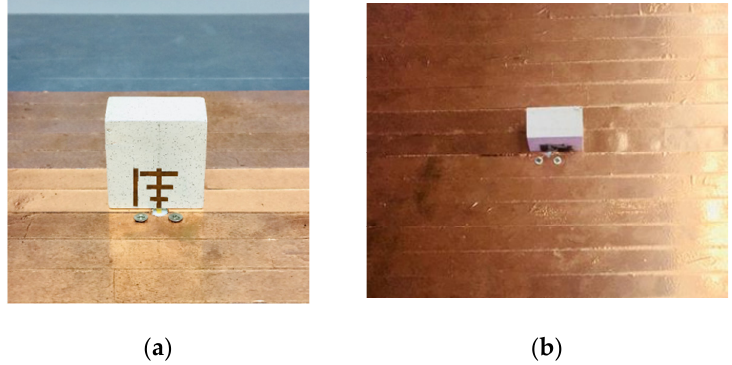
Figure 11. Photo of fabricated singly fed RDRA with parasitic patch: ( a ) front view and ( b ) back view.